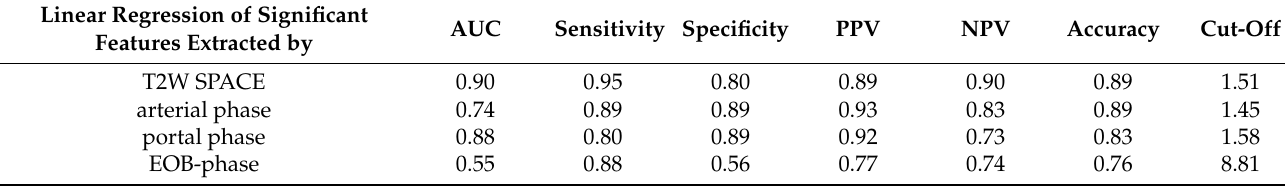
Table 4. Linear regression with significant features.